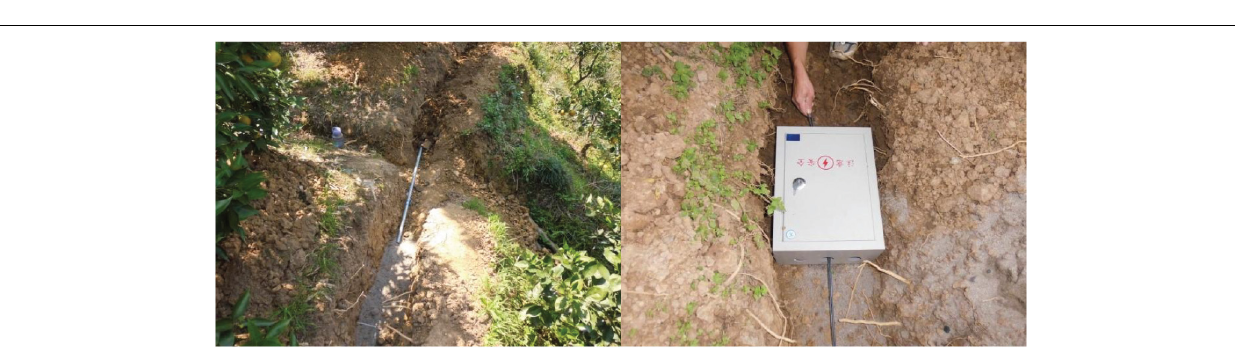
FIGURE 4 | Excavation and wiring site construction.